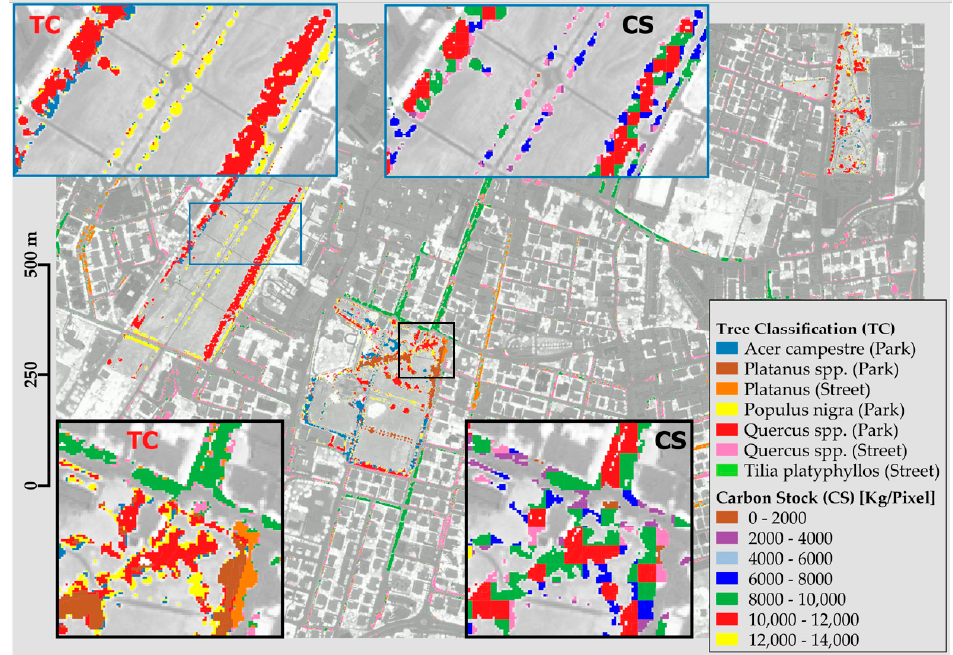
Forests 2020 , 11 , x FOR PEER REVIEW 13 of 21 spp. , Populus nigra, and Quercus spp. in the parks. Maximum values were generally found for Acer campestre (park) and Platanus spp. (street), while lower values were found for Quercus spp. (street), as in previous studies [111]. Figure 10. Comparison of the estimated CS (QGIS) for the dominant species in the parks and streets.